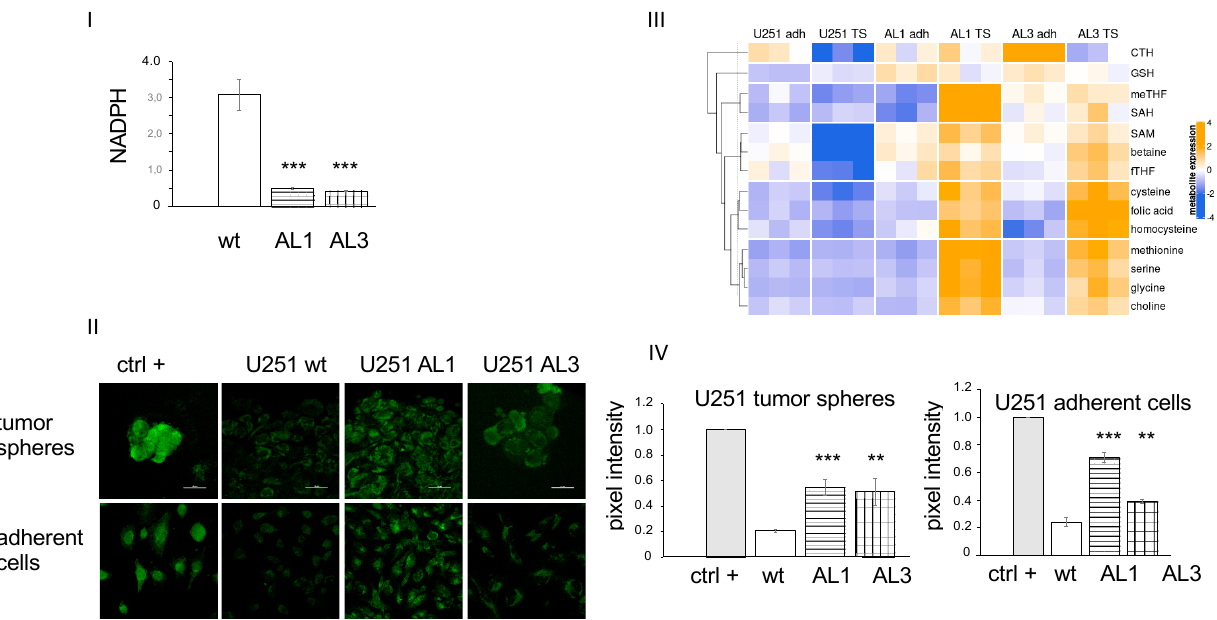
Figure 3. ALDH1L2 knockout U251 cells have lower NADPH level ( I ), no difference in GSH ratio (reduced GSH/total GSH) ( II ), and higher one carbon metabolites, including methionine, 5, methyl- tetrahydrofolate and formyl-tetrahydrofolate ( III ), as well as larger ROS production ( IV ). Tumor spheres were collected at passage 3 and adherent cells at 80% confluency. AL1 and AL3 were com- pared to U251 wild type, n = 6, ** p < 0.01, *** p < 0.001, AL1 = ALDH1L2 exon1 KO, AL3 = ALDH1L2 exon 3 KO.